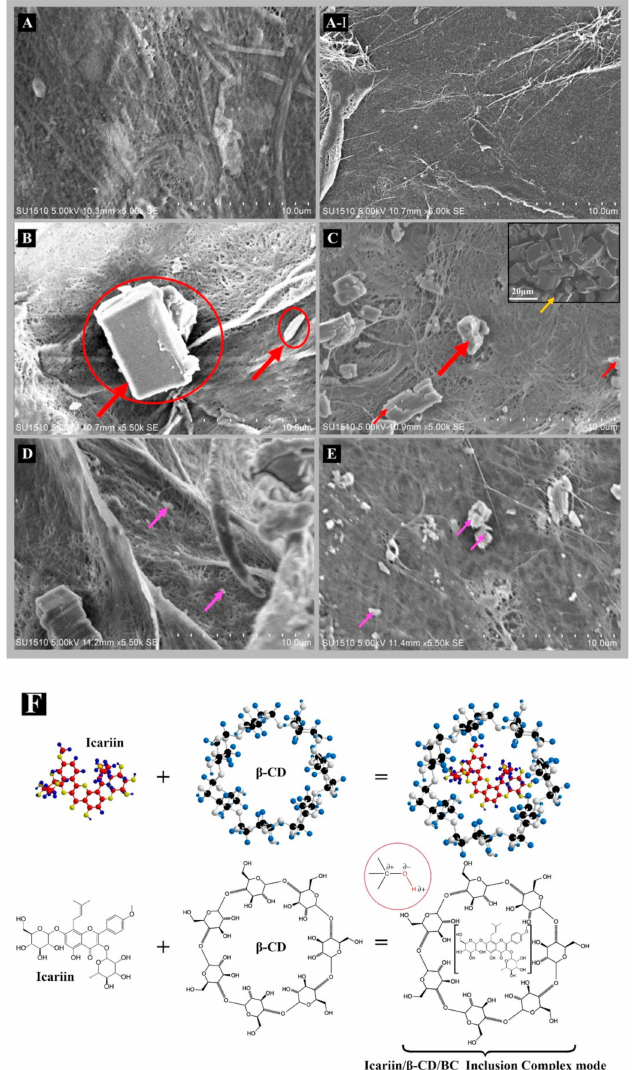
Figure 2. SEM images of ( A ) Pure BC, ( A-I ) ICrBC ( B ) IC/P/BC 50 (red arrows in both ( B , C ) indicate the inclusion complexed icariin within the β -CD cavities showing the typical block-like appearance, ( C ) IC/P/BC 100 (insert: image of pure β -CD inclusion complex block-like units with a yellow arrow), ( D ) IC/BC 50 (pink arrows in both ( D , E ) indicate aggregated chips potentially with icariin, ( E ) IC/BC 100. ( F ) Molecular structures and Inclusion complexation mode of Icariin/ β -CD-IC/BC (coded as IC/P/BC)